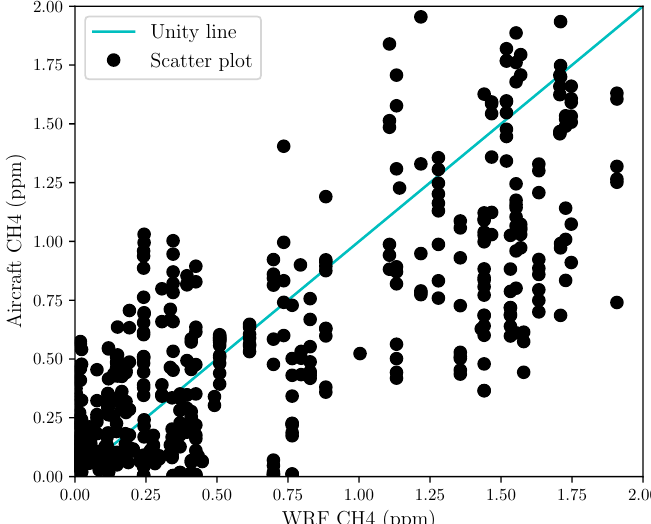
Figure 8. Comparison of aircraft observations and WRF predictions of methane mixing ratio at 1100 LST on 31 May 2018 ( R 2 = 0.68); the background mixing ratio of methane is subtracted from the aircraft